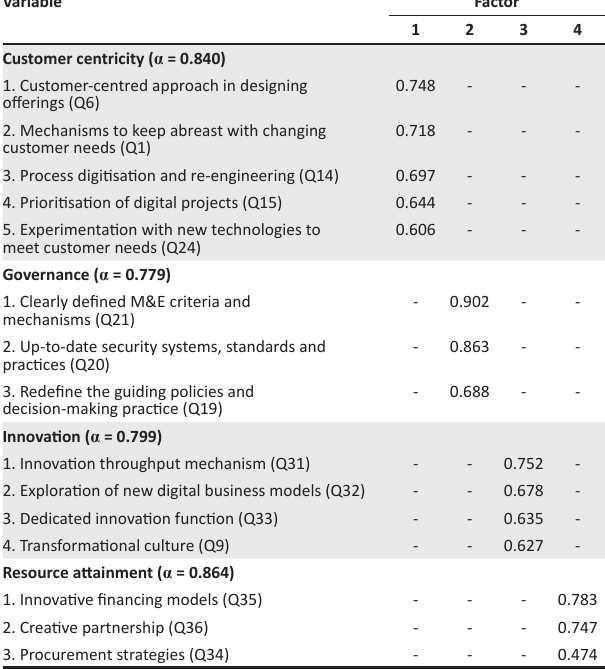
TABLE 5: Rotated factor